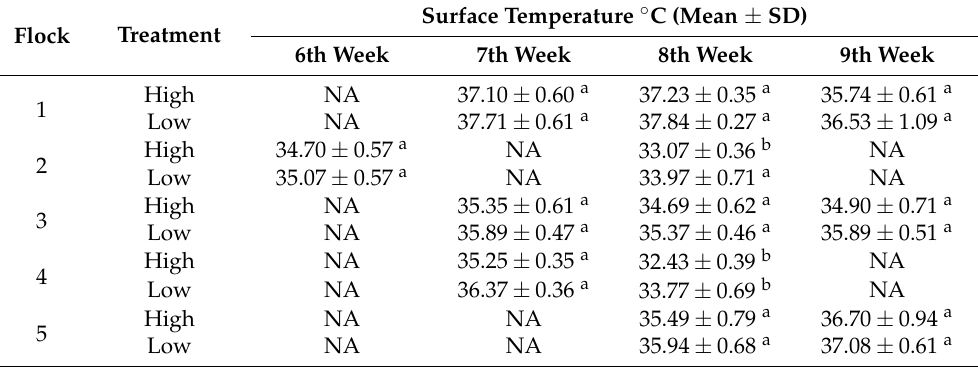
Table 8. Heavy broilers’ surface temperatures variation with age.